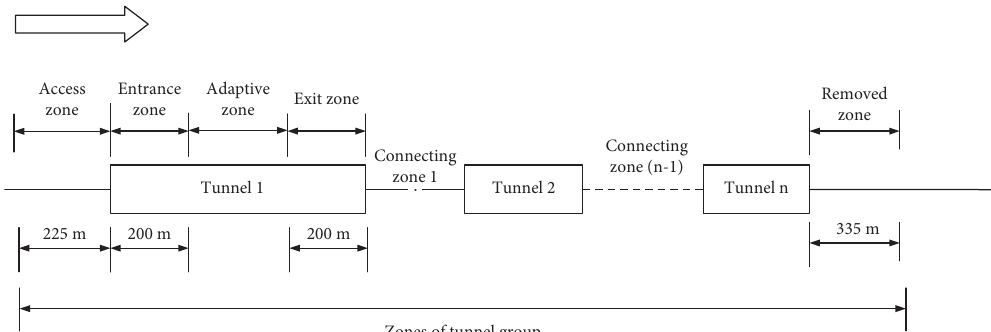
Figure 9: Section divisions of tunnel groups.